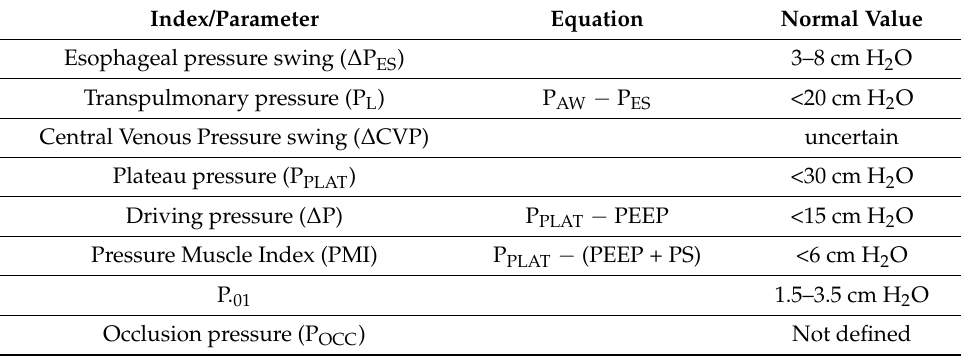
Table 1. Indexes and parameters with relative equation and normal